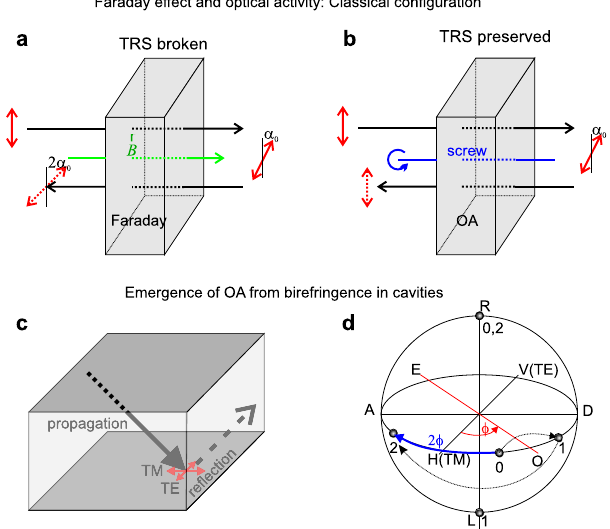
Fig. 1 Faraday effect and optical activity. Scheme showing the rotation α 0 of the linear polarization (red double arrow) of light while making a back and ! forth trip, in the Faraday effect ( a , TRS broken by magnetic fi eld B - green) and in a chiral OA structure ( b , TRS not broken, screw axis in blue). Black arrows indicate the propagation direction. c Propagation and re fl ection of light in a cavity with a birefringent active region; d Poincaré sphere showing the polarization states ( “ 0 ” - initial, “ 1 ” - after propagation, “ 2 ” - after re fl ection) and the inversion axes (TE-TM - transverse-electric/transverse-magnetic, OE - ordinary-extraordinary, rotated by ϕ ), as well as the polarization basis (H-horizontal, V - vertical, D - diagonal, A -anti-diagonal, R - right-circular, L - left-circular). After propagation and re fl ection, linear polarization is rotated by 2 ϕ vector of a propagating beam with respect to the ordinary- extraordinary axis (marked “ OE ” on the Poincaré sphere in Fig. 1d). The initial polarization of the beam is marked “ 0 ” , and the state after the propagation is marked “ 1 ” . But the re fl ection on a metallic mirror also leads to the polarization inversion with respect to a different axis (TE-TM or HV in this case, also marked in Fig. 1c, d), except the normal incidence case, which gives the fi nal polarization state marked “ 2 ” . Mathematically, two inver- sions (black dashed arrows) are equivalent to a rotation (blue arrow) by the double of the angle ϕ between the axes of inversion (also marked in Fig. 1d), which means that any linear polarization is not an eigenstate of this system for a beam with non-zero in- plane wave vector. On the contrary, the circular polarization, inverted twice, recovers the original state ( “ 2 ” = “ 0 ” , marked in Fig. 1d), which shows that the eigenstates are circular-polarized.